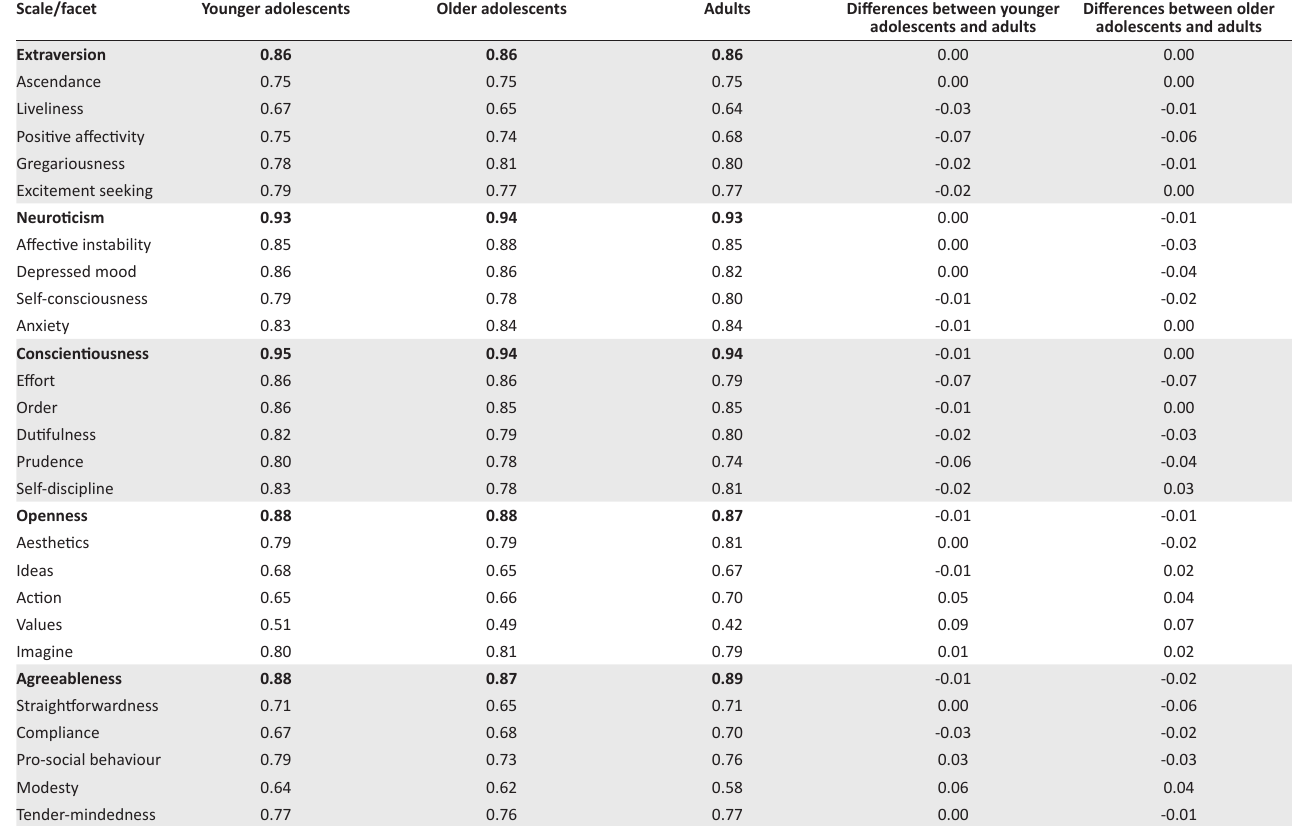
TABLE 4: Reliability coefficients of the Basic Traits Inventory scales and facets for adolescents and adults.